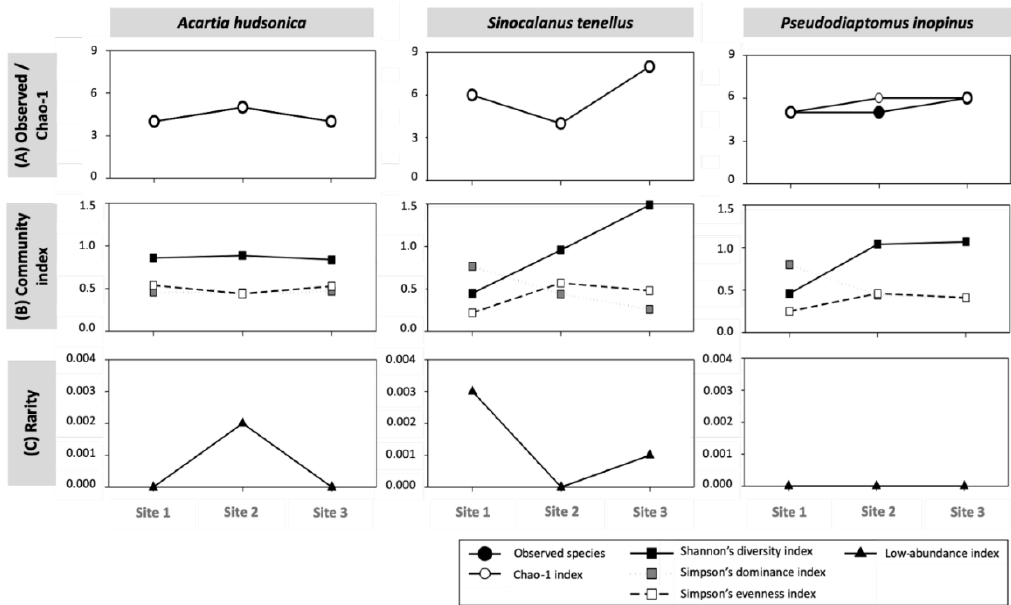
Figure 4. Comparison among bacterial alpha diversity indices of copepod species— Acartia hudsonica , Sinocalanus tenellus , and Pseudodiaptomus inopinus —by site. ( A ) Observed/Chao-1: observed species (black circle) and Chao-1 index (white circle), ( B ) community indices: Shannon’s diversity index (black rectangle), Simpson’s dominance and evenness indices (grey and white rectangles, respectively), ( C ) rarity: low-abundance index (black triangle).